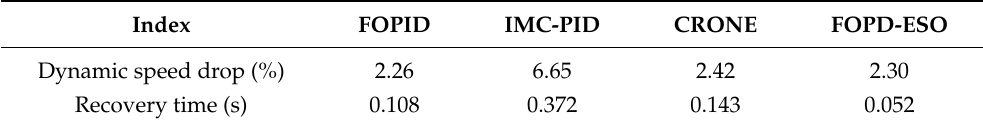
Figure 10. Load disturbance response comparisons. ( a ) FOPID. ( b ) IMC-PID. ( c ) CRONE. ( d ) FOPD-ESO. Table 6. Load disturbance response performance indices of the systems